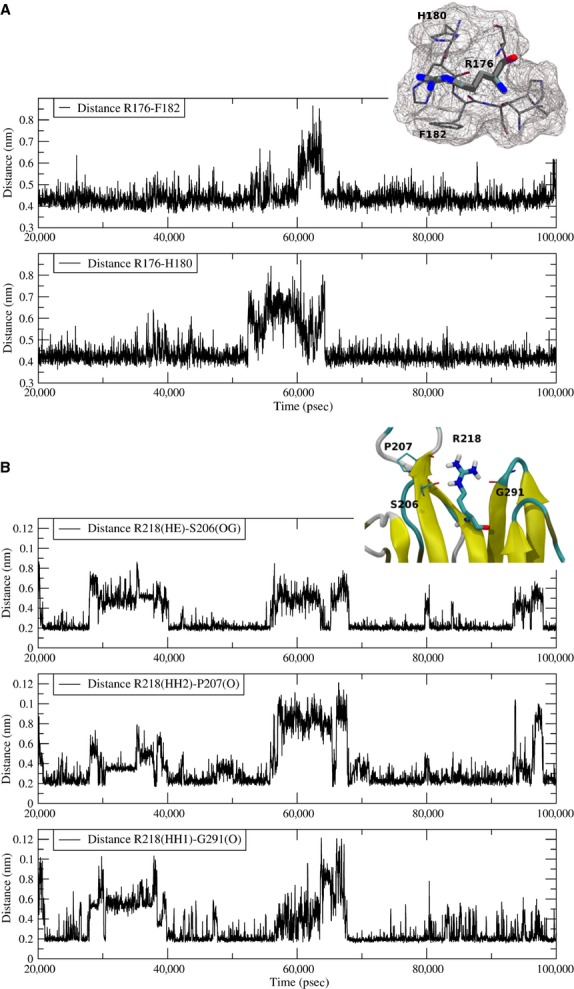
Aromatic cage around R176 and H-bonds network involving R218. (A) Representation of the distance between the centre of mass of R176 and F182 and of R176 and H180 side-chains as a function of time. Distances were monitored during the last 80 nsec. of simulation. In the inset, the surface of the cage-like structure is shown as wireframe. (B) Distances between R218 and S208, P207 and G291 are shown as a function of time. In particular, distance among R218HE-S206OG, R218HH2-P207O and R218HH1-G291O was monitored during the last 80 nsec. of simulation.